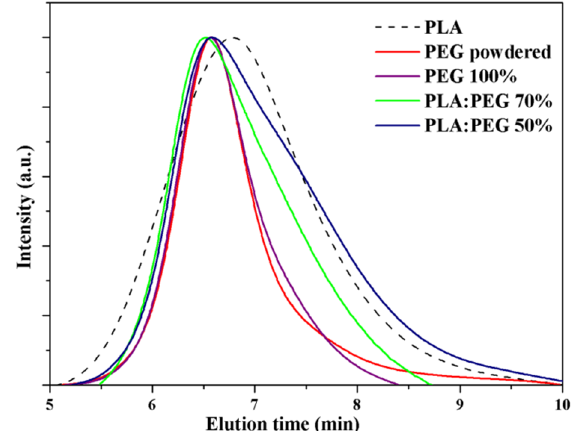
Figure 5. Gel permeation chromatography (GPC) profiles of powdered polyethylene glycol (PEG), micromolded PEG and PLA/PEG blends having 30 wt-% and 50 wt-% of PEG. The curve of a micromolded PLA specimen (dashed line) is also given for comparison purposes.